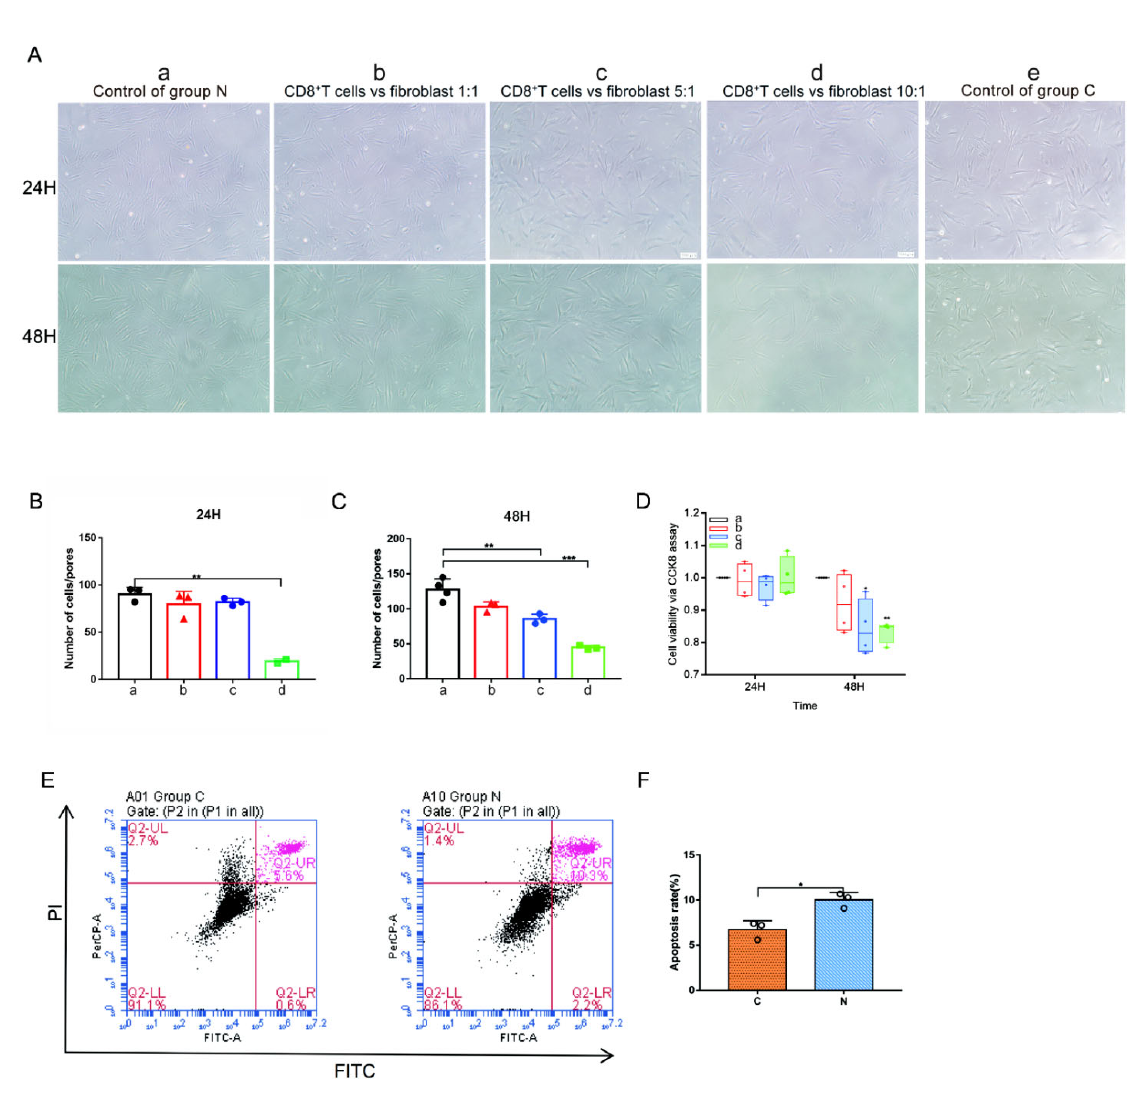
Figure 9. Fibroblasts from patients with keloids were cocultured with CD8 + T cells in a Transwell suspension noncontact coculture system. The number of fibroblasts analyzed was measured by mi ‐ croscopy at 100×, n = 3. ( A ) The sorted CD8 + T cells and fibroblasts isolated from keloid tissue were cocultured in a Transwell suspension noncontact coculture system. In Group a, only fibroblasts from keloid patients were cultured. In Group b, the ratio of CD8 + T cells to fibroblasts was 1:1. In Group c, the ratio of CD8 + T cells to fibroblasts was 5:1. In Group d, the ratio of CD8 + T cells to fibroblasts was 10:1. The number of fibroblasts growing in Group d was significantly reduced compared with that in Group a at 24 h and 48 h. In Group e, only fibroblasts from cosmetic patients were cultured. ( B ) The numbers of fibroblasts growing in Groups a–d at 24 h. ( C ) The numbers of fibroblasts grow ‐ ing in Groups a–d at 48 h. ( D ) The measure of cell viability via CCK8 assay at 24 h and 48 h. ( E , F ) The apoptosis rate (%) was measured by a CoraLite ® 488 ‐ Annexin V and PI Apoptosis Kit. Group C: Fibroblasts without coculture at 48 h. Group N: Fibroblasts from patients with keloids cocultured with CD8 + T cells directly at 48 h. The ratio of CD8 + T cells/fibroblasts in Group C was 5:1. * p < 0.05, ** p < 0.01, *** p < 0.001.